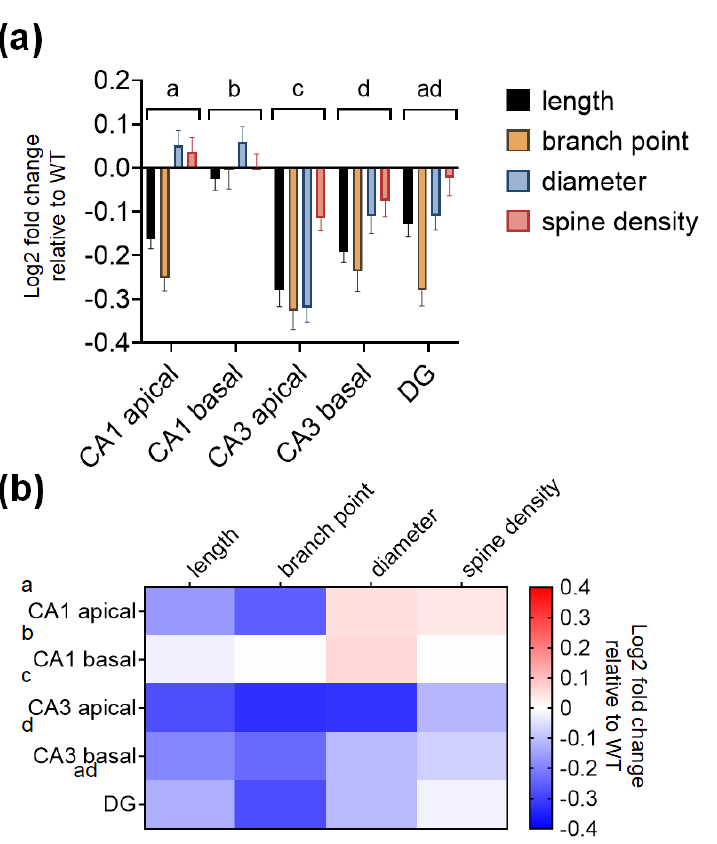
Figure 5. SREBP-1c KO mice show greater morphological alterations in the CA3 than in the other subregions of the hippocampus. Fold changes in dendritic and spine morphological characteristics in WT mice are represented as bar graphs ( a ) and heatmaps ( b ) to better visualize the degree of differences between the different hippocampal subregions (CA1, CA3, and DG). Data are expressed as means ± SEs, and different letters, “a,” “b,” “c,” and “d,” indicate statistically significant differences between the subregions at p < 0.05 ( n = 40 neuron or dendrites/group). Bars with no common letters are significantly different ( p < 0.05). CA, cornu ammonis ; DG, dentate gyrus; WT, wild-type littermate group. Table 5. Results of two-way ANOVA tests for the effects of the hippocampal subregion and mor- phological parameters on log2 fold changes in KO mice relative to WT mice.